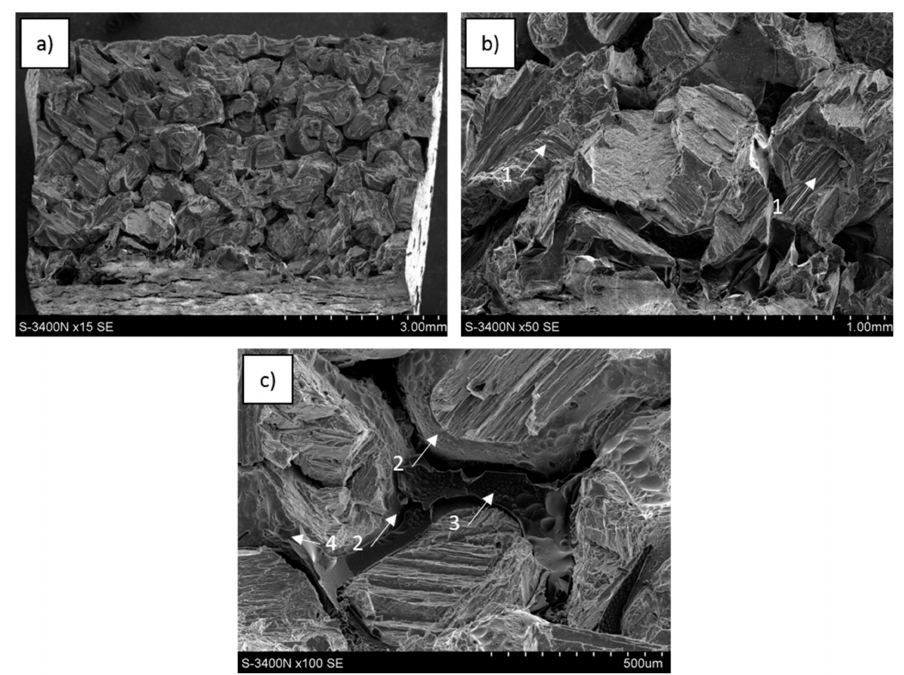
Figure 15. SEM images of C of 45pp–Mg composite fractured during three-point bending strength testing: ( a ) metal cells surrounded with a glassy carbon network, ( b ) di ff erently oriented shear bands (1) in metal matrix and fragmented foam, ( c ) metal areas with shear bands surrounded with degraded cells of carbon foam, the metal surface after foam delamination (2), foam surface after metal delamination (3), fractured foam surface (4).